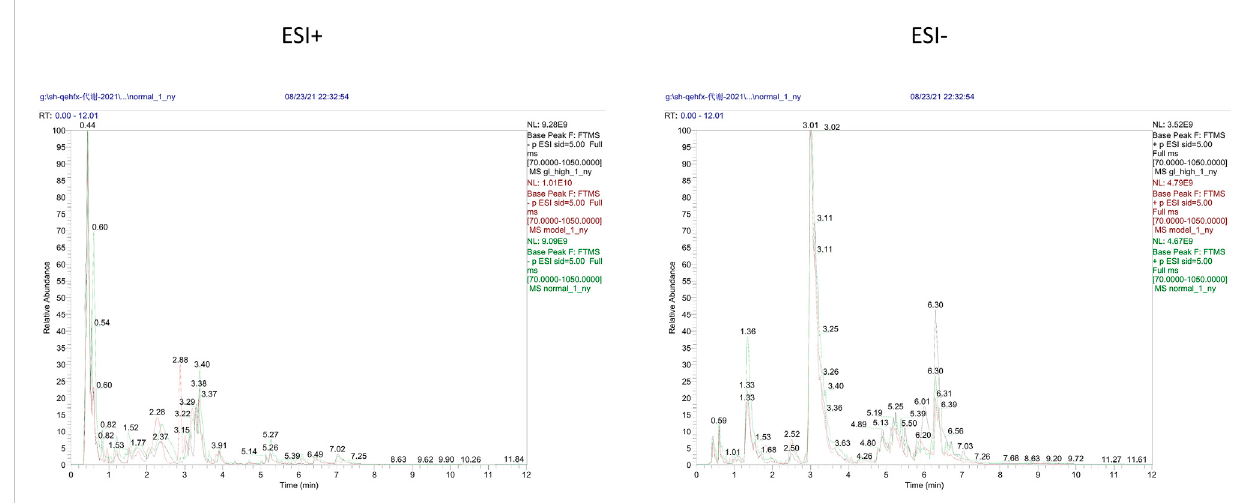
FIGURE 9 Representative BPC graph of rat urine in positive and negative ion mode for each